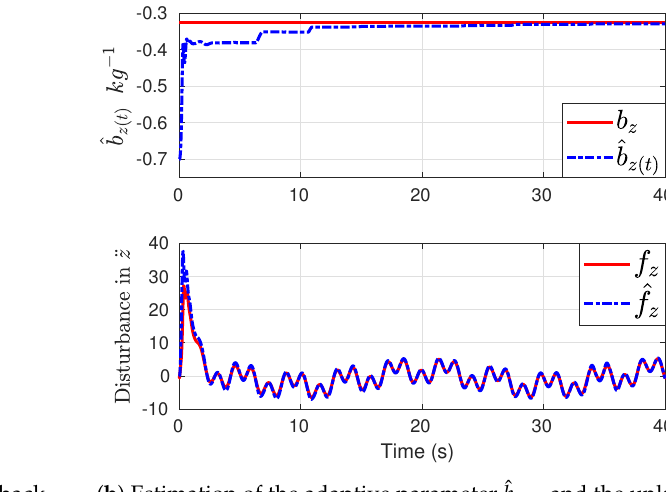
( b ) Estimation of the adaptive parameter ˆ b z ( t ) and the unknown function ˆ f z . Figure 4. Simulation results for trajectory tracking in Z